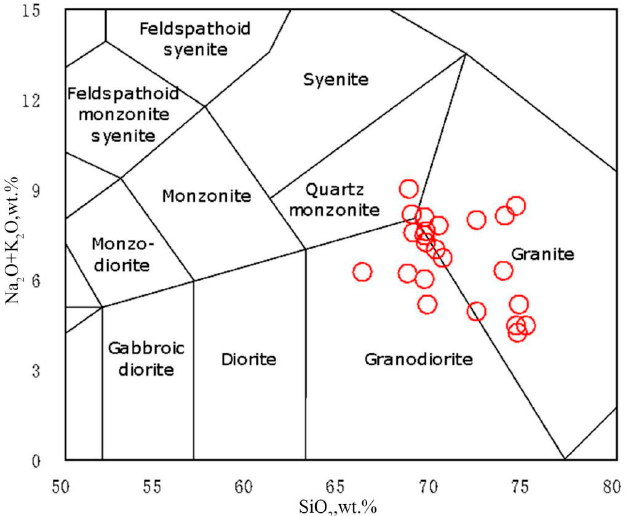
Figure 4. Total alkali vs. silica (TAS) plot of the Dahongliutan pluton samples (according to Mid- dlemost, et al. [16]). most, et al. [16]).